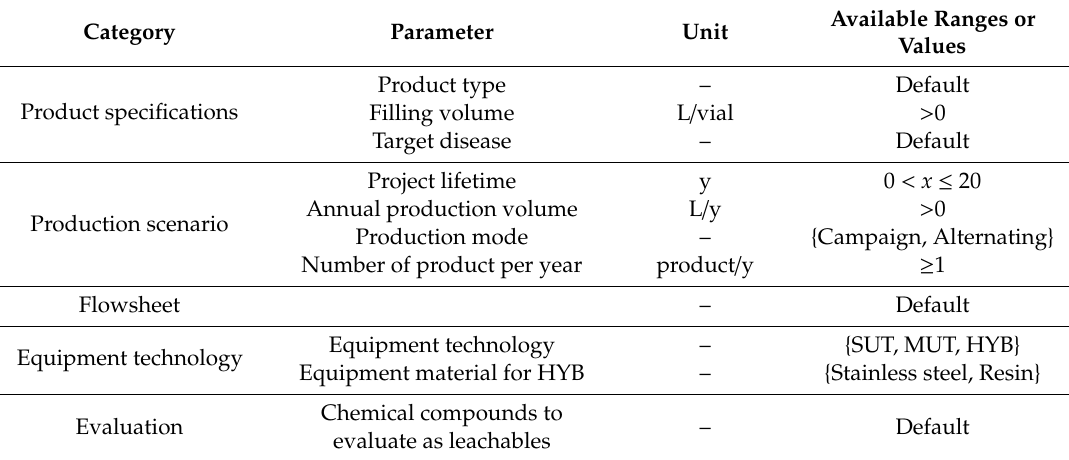
Table 3. Possible range of input